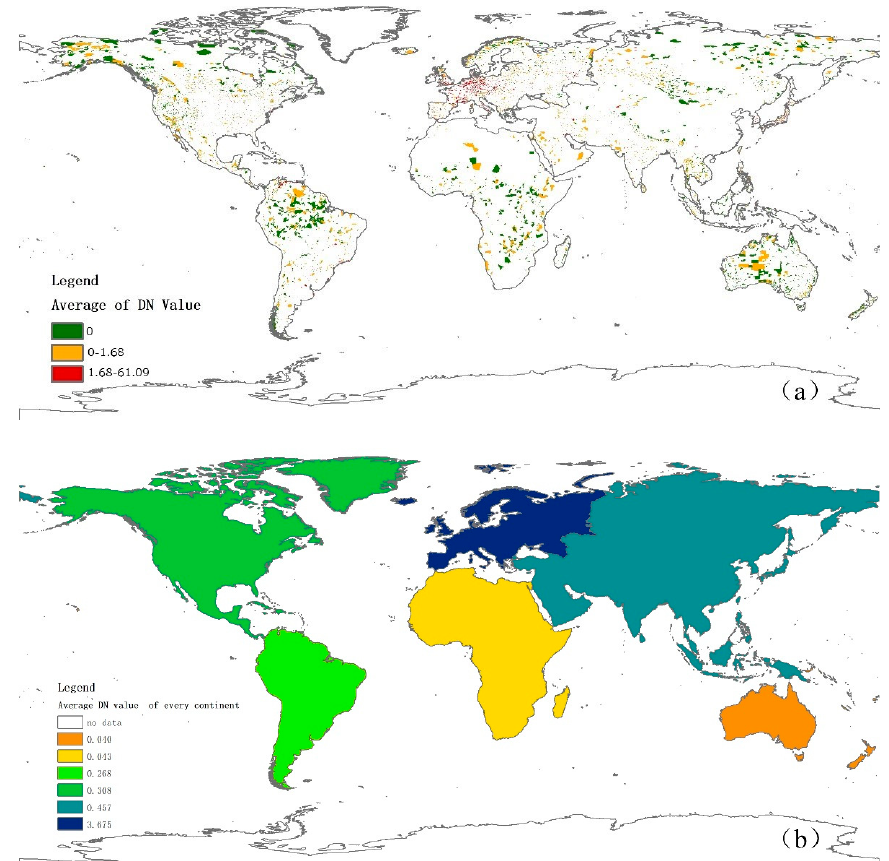
Figure 4. ( a ) Average NTL DN value for every PA and ( b ) average NTL DN value for every continent. For ( a ), we used the natural breaks (Jens) method to divide the PAs into three levels according to the average DN value. The green-colored PAs were those with the average value of 0, the yellow-colored PAs had a lower than average DN value, and the red-colored PAs had a higher than average DN value. For ( b ), the ranking of the average NTL DN value of PAs in each continent gave the order as Europe > Asia > North America > South America > Africa > Oceania.